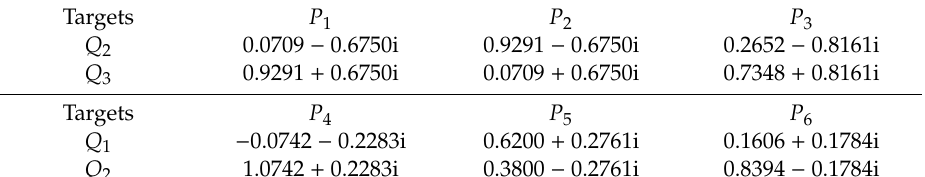
Table 4. Complex coe ffi cients of di ff erent false targets corresponding to two transponders.